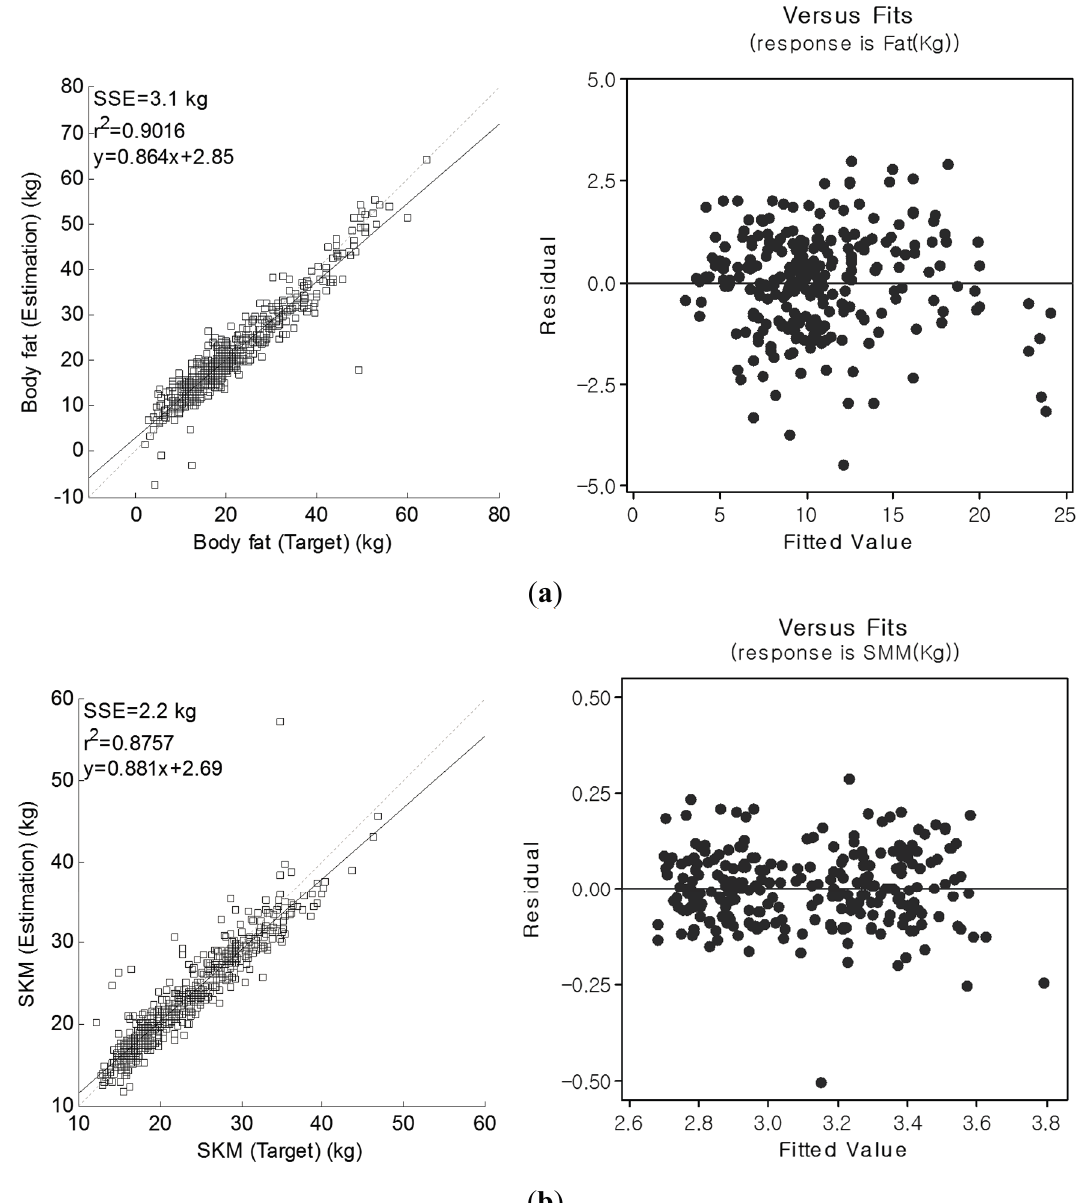
Figure 5. Regression and complementary residual vs. fitted plots of the PP pathway for ( a ) body fat (kg) and ( b ) skeletal muscle mass